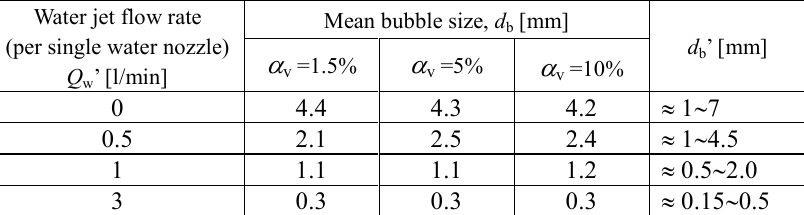
Table 1. Mean bubble size under different flow rate